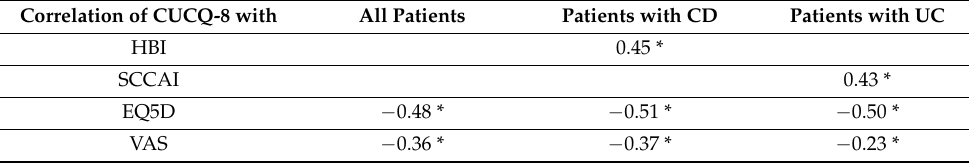
Table 5. Pearson correlation coefficient between CUCQ-12 and with other measures. Correlation of CUCQ-8 with All Patients Patients with CD Patients with UC HBI 0.45 * SCCAI 0.43 *